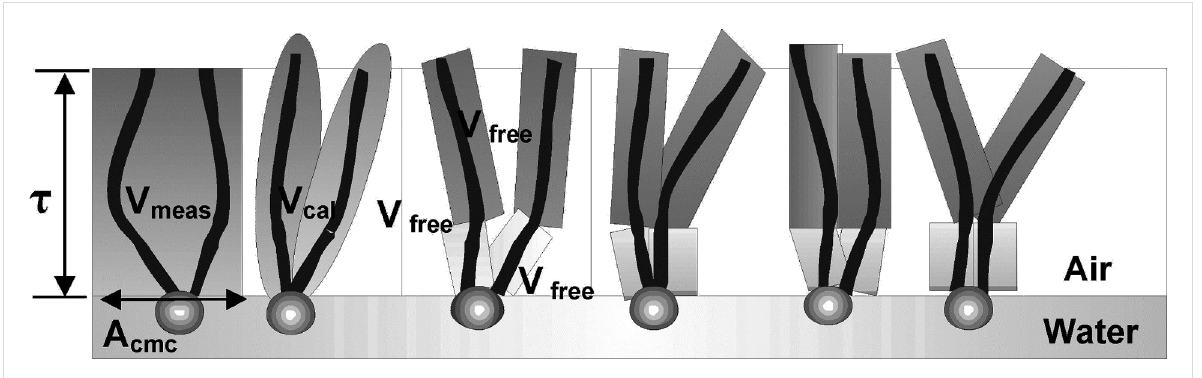
Figure 1: A visual representation of fluorocarbon surfactants at the air–water interface, highlighting the fragment and interfacial volumes is used to calculate the surface coverage ( Φ surf ). The measured surfactant molecular volume is V meas and the calculated volume is V cal , based on the summa- tion of fragments and the free space in the interface V free . Reprinted with permission from [72]. Copyright 2011 American Chemical